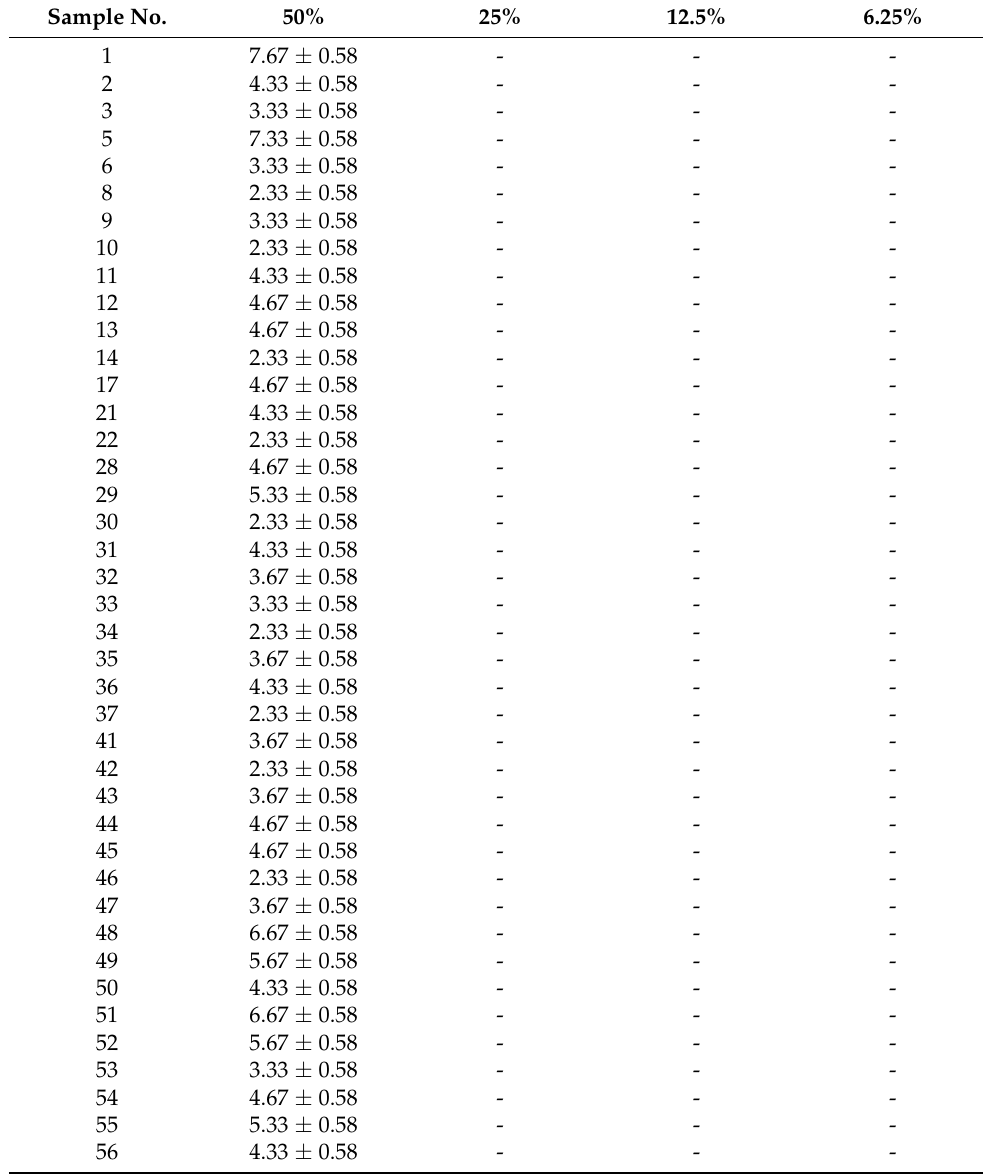
from a beekeeper from a town (Table 6). In the 6.25% concentration, only one sample showed an antagonistic effect against this microbe which was sample no. 4, multifloral honey from a beekeeper from a town. Values of the inhibition zones for the 50% honey samples in the tests against yeasts are shown in Tables 7–10. The antimicrobial activity against C. albicans ranged from 0.00 to 7.67 mm. The best antimicrobial activity was found in honey samples no. 1 and 65. No 1. was a multifloral honey from a beekeeper from a town and no. 65 was a sunflower honey from a beekeeper of the countryside. Comparing the activity of honey to antifungal fluconazole, a stronger antimicrobial effect was found in fluconazole (20.33 mm) (Table 7). In 18 samples of the 50% honey, antimicrobial activity against C. albicans was not found. Table 7. Antimicrobial activity of samples against C. albicans in mm. Sample